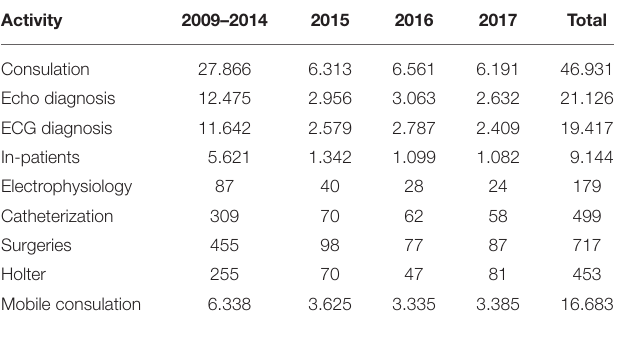
TABLE 5 | Productivity enhancement since